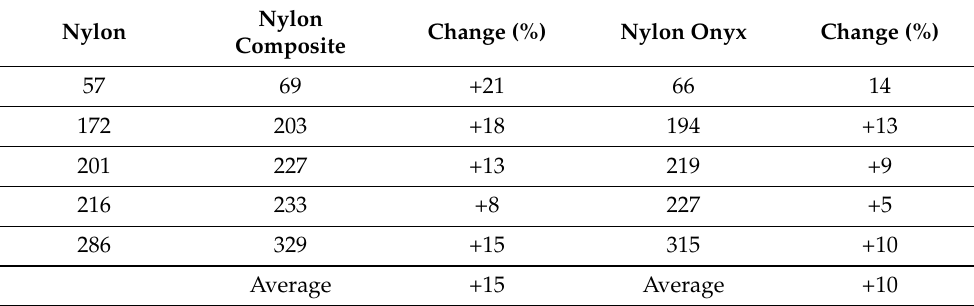
Figure 11. MAC analysis results for re-entrant lattice structure: Bottom-clamped. Table 11. First five natural frequencies of re-entrant lattice structure in the bottom-clamped boundary condition and the paired modes when the material of vertical parts of honeycomb lattice structure changed to composite or